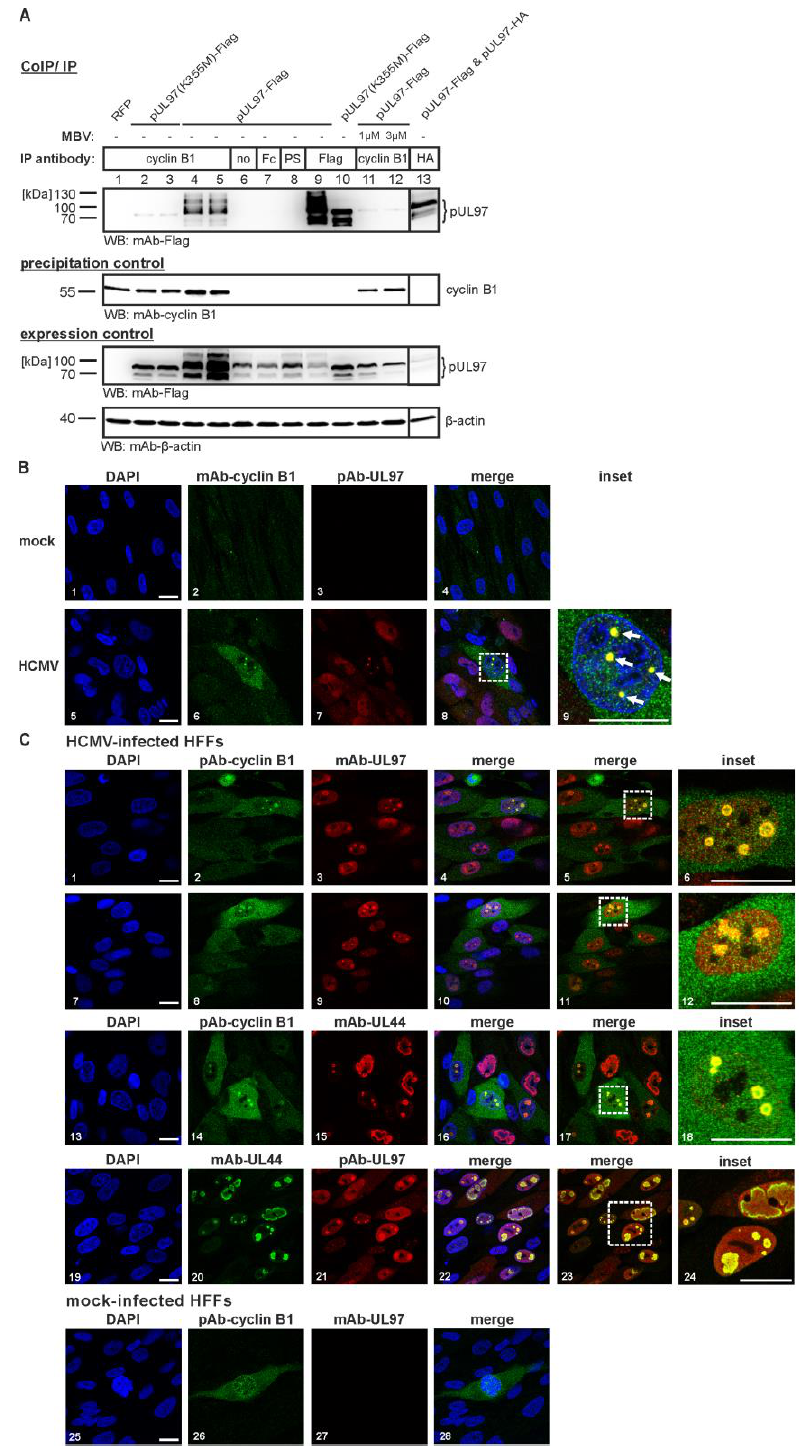
Figure 1. Interaction between HCMV pUL97 and endogenous cyclin B1. ( A ) CoIP analysis showing an activity-dependent interaction between pUL97 and cyclin B1. pUL97-Flag and the catalytically inactive mutant pUL97(K355M)-Flag were transiently expressed in 293T